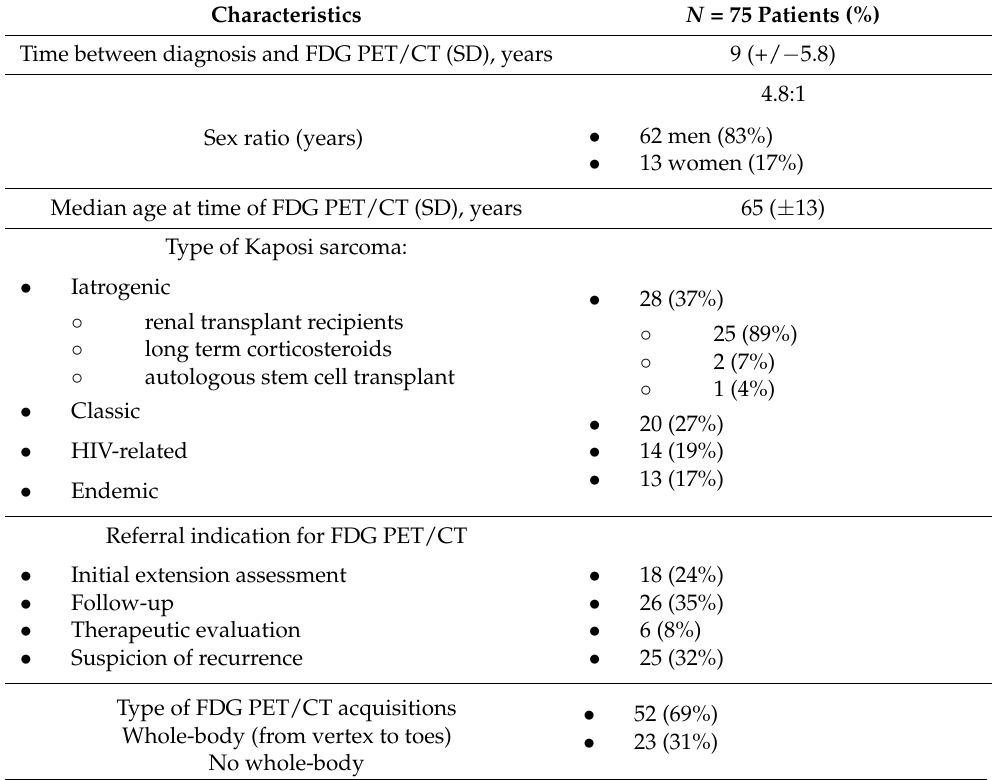
Table 1. Patients’ characteristics.